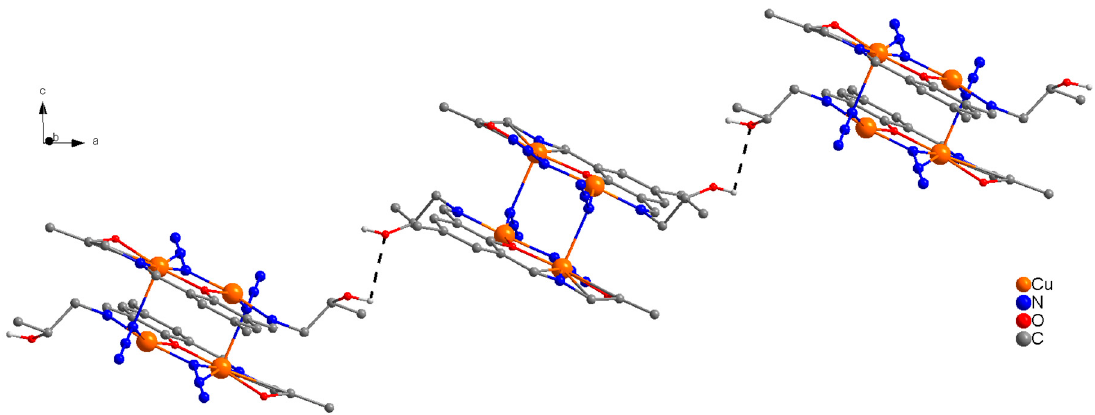
Figure 3. Perspective view of the crystal packing of 1 as seen along the a -axis generating 1D-single chains via protonated uncoordinated hydroxy groups in the side arm of the ligands.